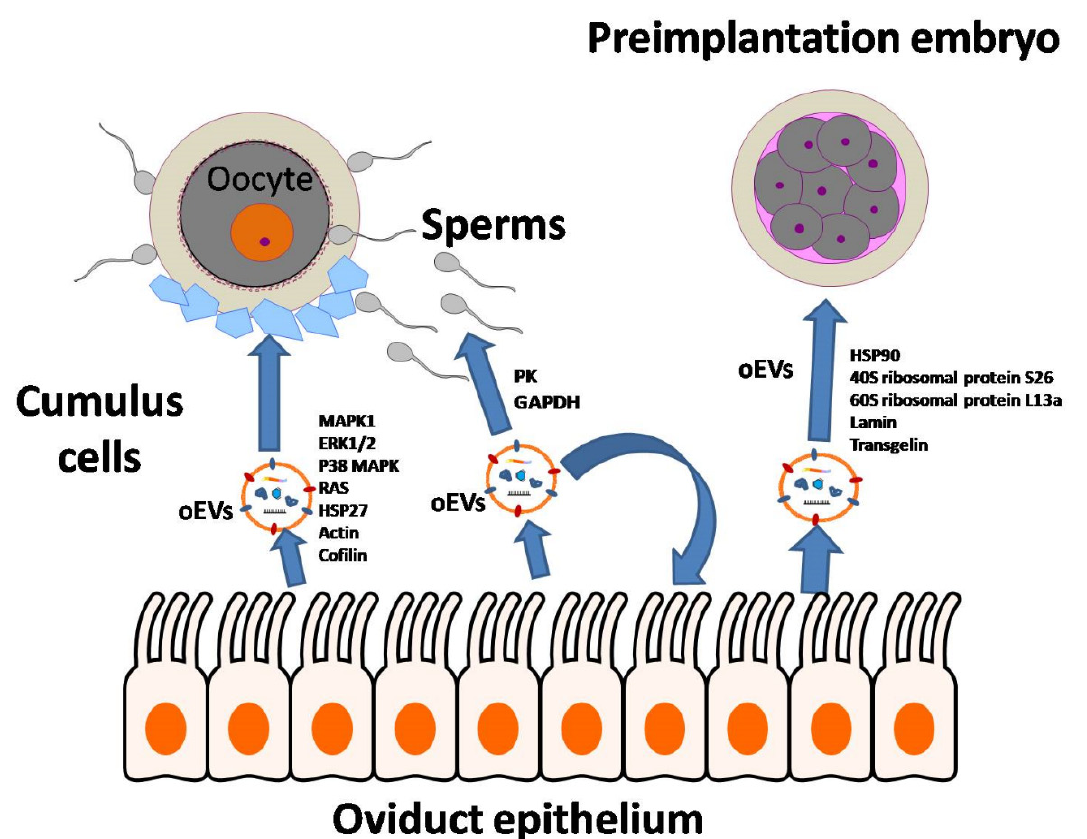
Figure 6. The proposed paracrine and juxtracrine actions of the oviductal cells-derived extracellular vesicles (OC-EVs) on the oocyte, sperms, embryos, and the oviduct cells. OC-EVs can mediate cargo transfer to the cells, such as the MAPK/ERK pathway, actin, and cofilin, for oocyte maturation and meiosis. Metabolic enzymes such as protein kinase (PK) and GAPDH can affect sperm metabolism as well. Moreover, some other proteins such as HSP90 and endoplasmic reticulum-related proteins can affect early preimplantation embryo development.